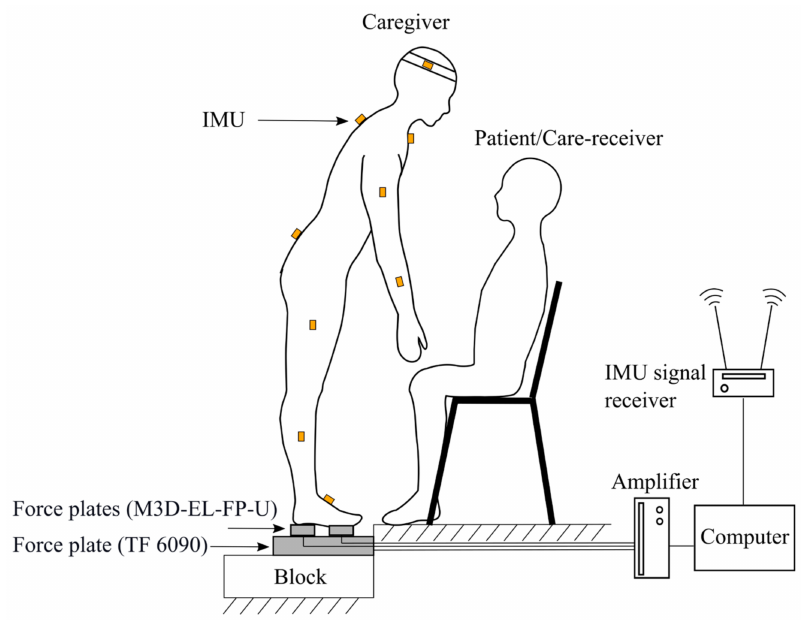
Figure 1. Schematic of the experimental setup for obtaining the ground reaction force and motions. A block was used to ensure the caregiver and patient were on the same horizontal level.